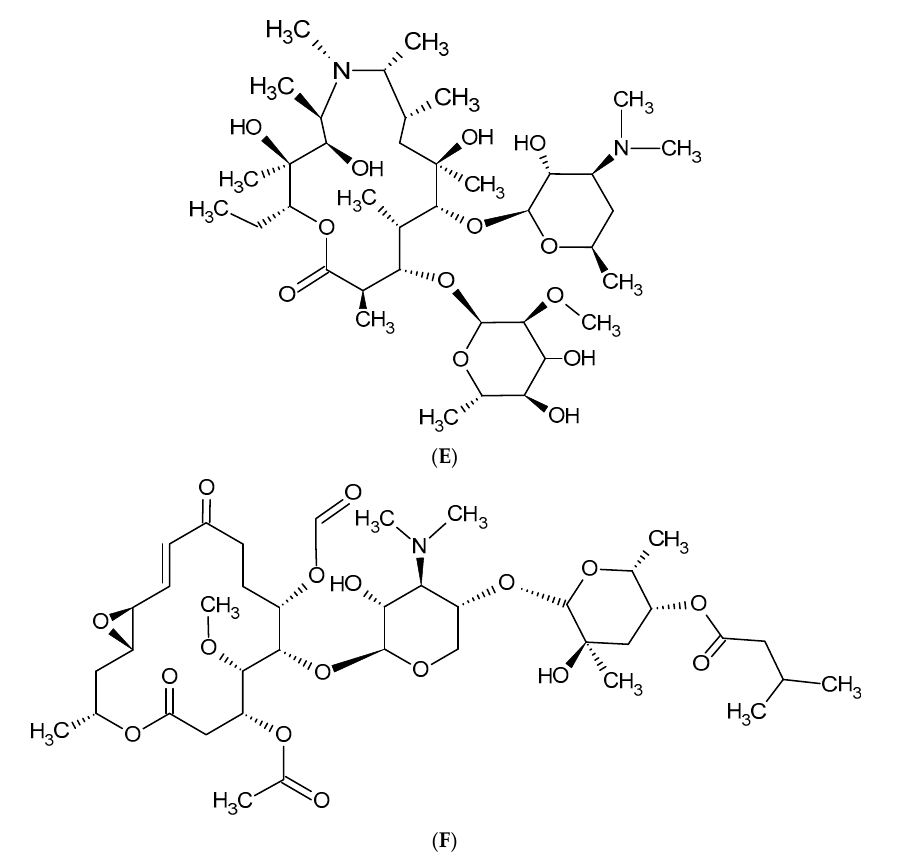
Figure 2. Methymycin ( A ), Erythromycin ( B ), Clarythromycin ( C ), Oleandromycin ( D ), Azithromycin ( E ), Carbomycin ( F ).